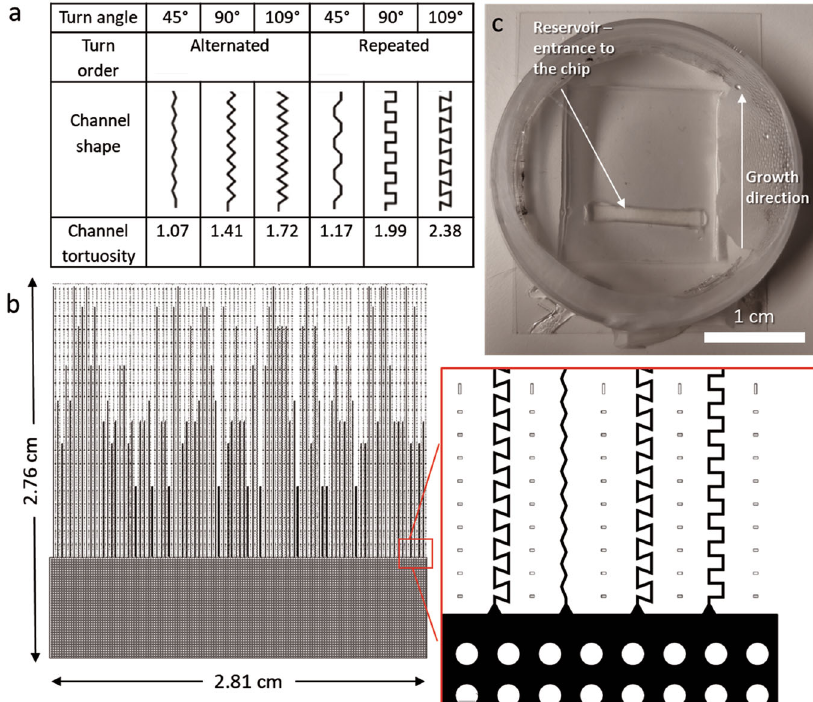
Fig. 5 Chip design and arrangement of channels. a Channel geometries used in the Channel chip. Each channel is characterized by one type of bending angle (45°, 90°, and 109°) and one turn order (alternated or repeated). The channel tortuosity is shown in the last row, which is here quanti fi ed as the ratio between the distance inside the channel between two points and the distance between the same points in a straight line. b Chip design, consisting of a pillar system serving as the entry area to the channels, and the array of channels in six variations, randomly distributed along the chip. Structures in black correspond to the open areas of the micro fl uidic chip pore space in the channels and the pillar system. The chip design dimensions were: 281 mm × 276 mm and the volume of each channel was 2.42 nl. c The PDMS chip bonded to a custom-made glass bottom Petri dish, containing the growth medium and microbial cultures introduced via the rectangular reservoir